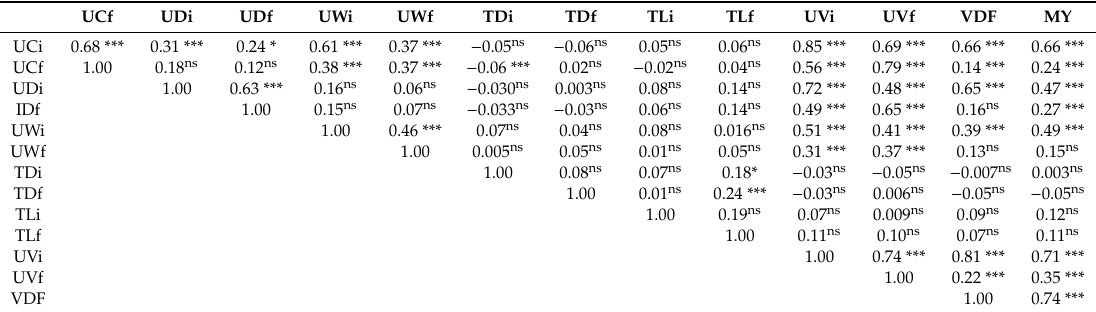
Table 2. Correlation coe ffi cients among measured variables for udder measurements and mean daily milk yield in Pelibuey